Question: From the figure, is the trend upward or downward?
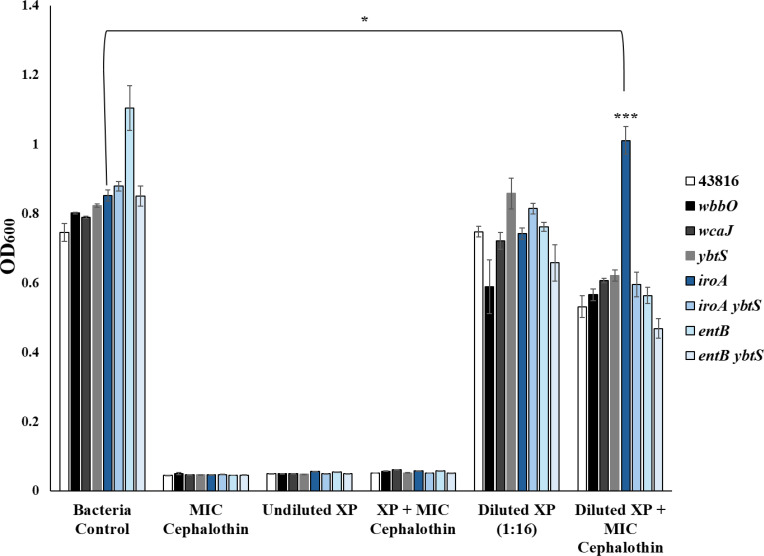
Answer: increasing